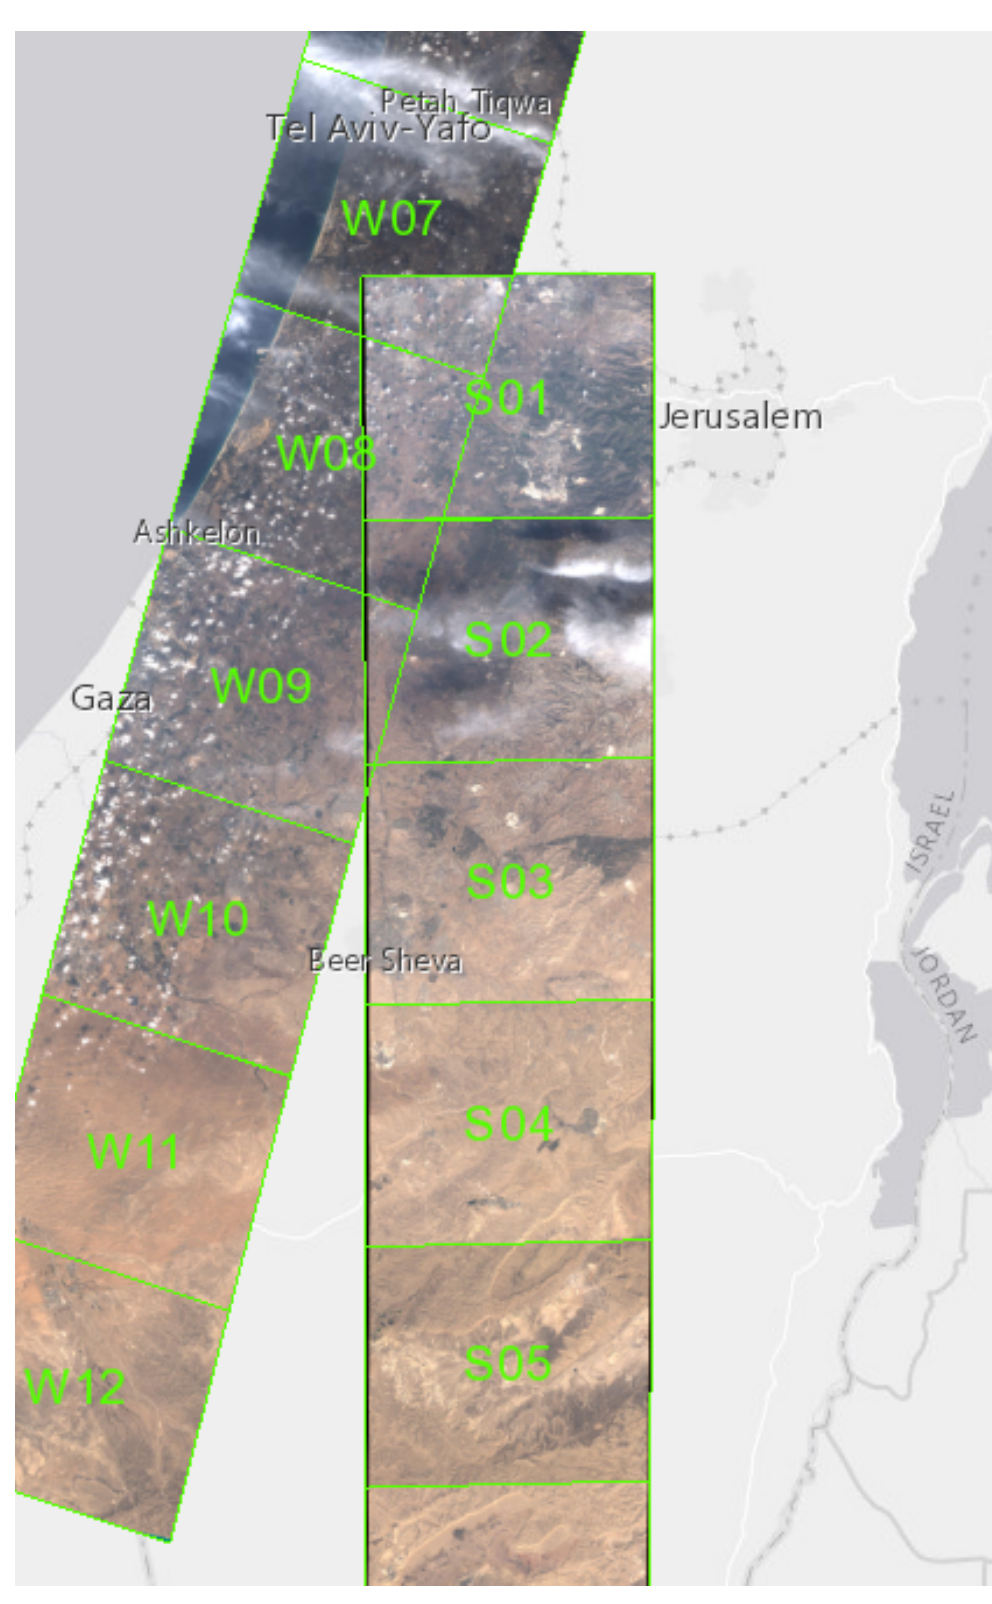
Figure 1. VEN µ S tile strips over